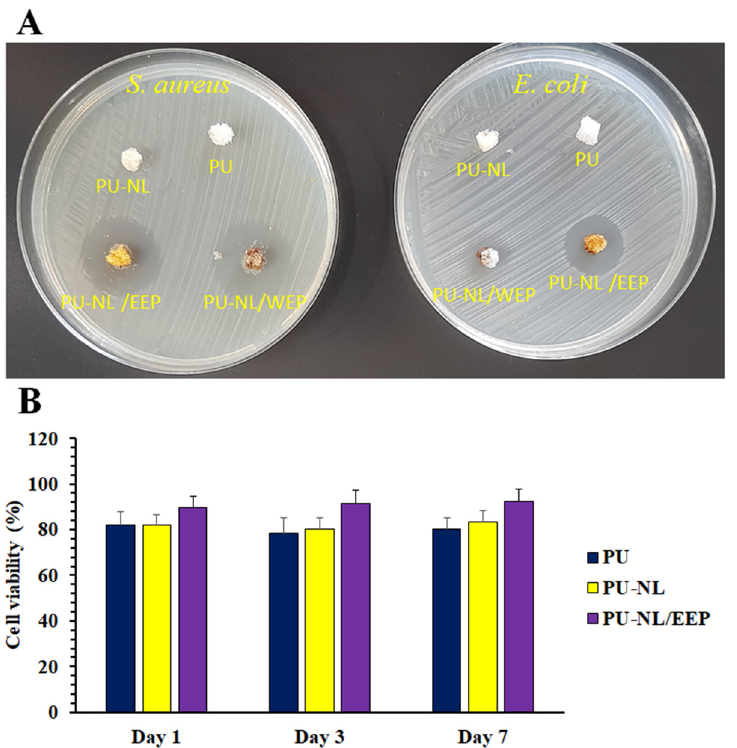
Figure 5. ( A ) The PU, PU-NL, PU-NL/EEP, and PU-NL/WEP films’ antibacterial activity against Staphylococcus aureus and Escherichia coli strains according to the zone of inhibition test. ( B ) Bio- compatibility of the PU, PU-NL, PU-NL/EEP films with L929 skin normal fibroblast after different incubation times according to MTT assay analyzes.